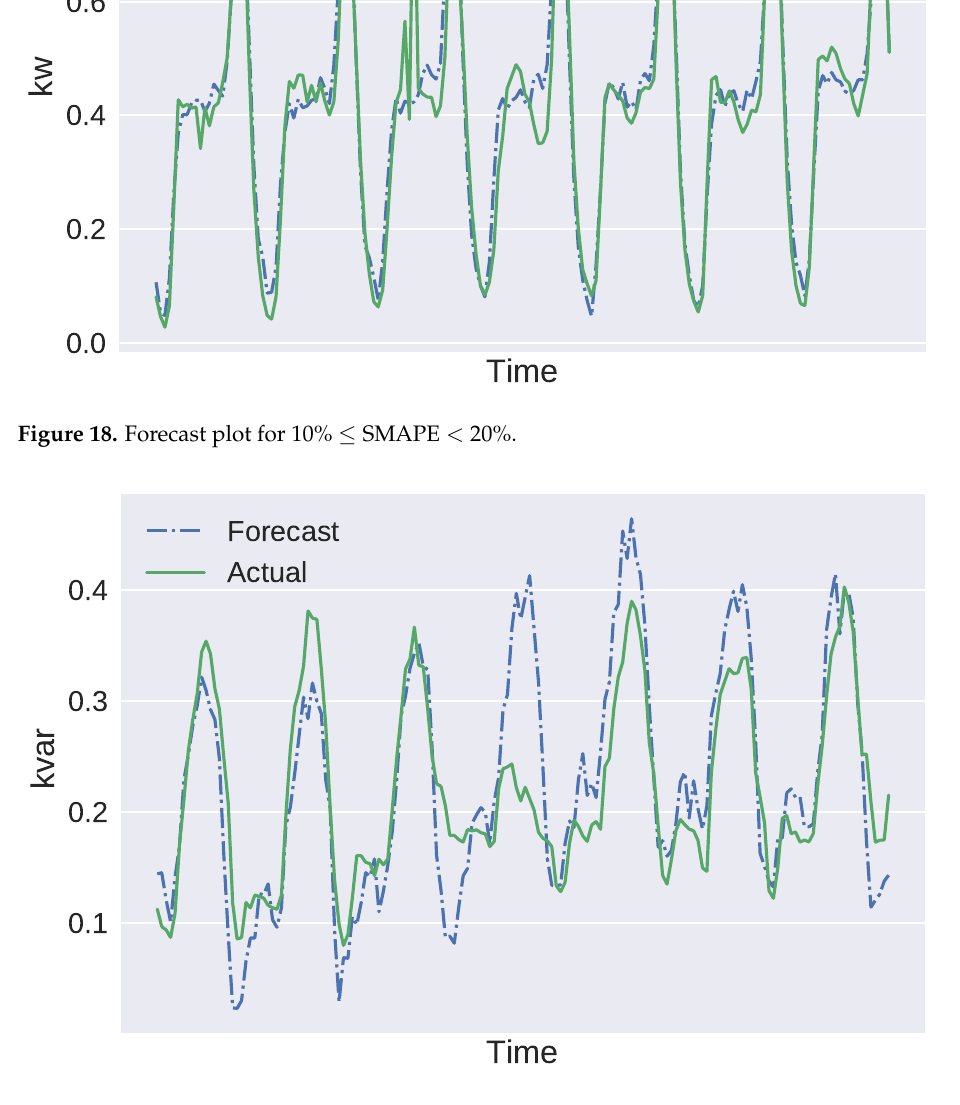
Figure 19. Forecast for SMAPE ≥